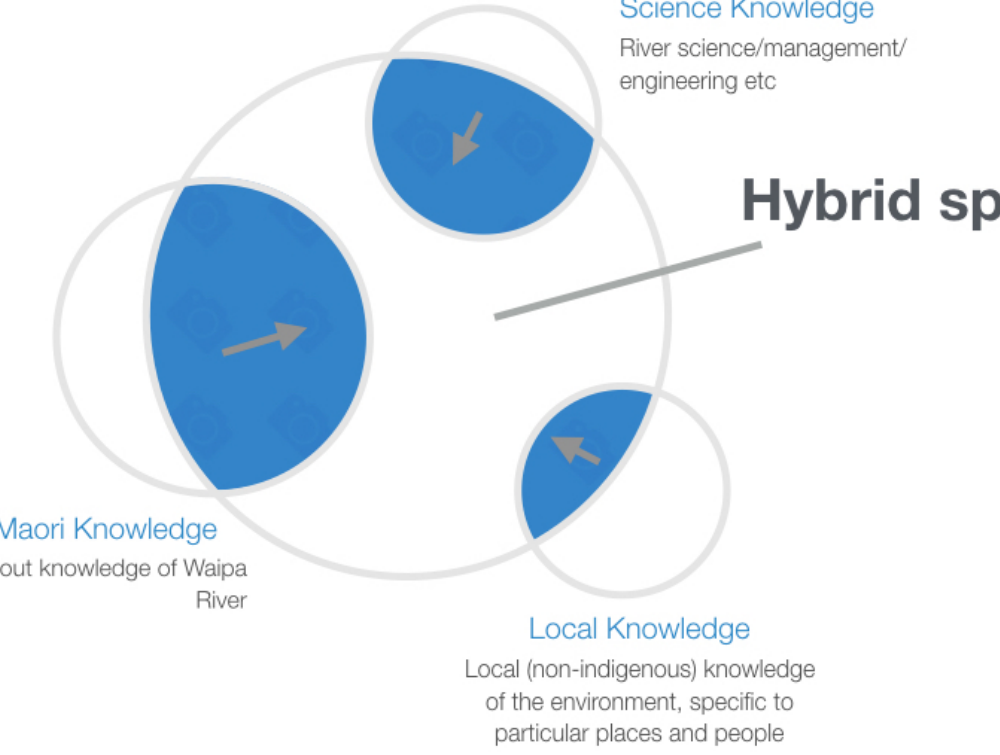
Figure 2. The different kinds of knowledge creating a hybrid knowledge space in the context of the Waip¯a River catchment and its